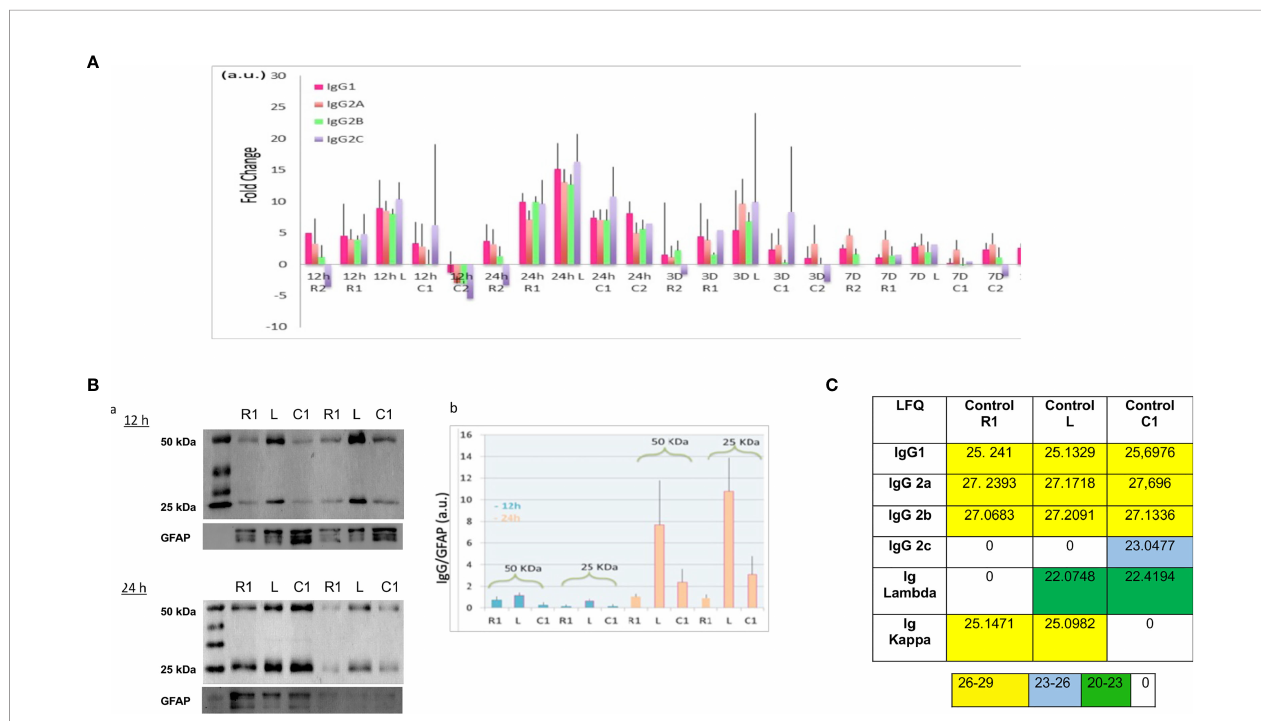
FIGURE 2 | (A) Ratio of IgG according to time course after SCI and spinal cord segment. Rationalization was performed by comparison with the control (non- lesioned spinal cord). (B) (a) Western blot of 12 h and 24 h secretomes, with anti-immunoglobulin antibodies. (b) Histogram illustrating the immunoglobulin level in function of time and segment was obtained by ImageJ software. Results rationalization was carried out using GFAP. (C) . Inset Table 3 . Immunoglobulin rates in control spinal cord. (LFQ: label free quanti fi